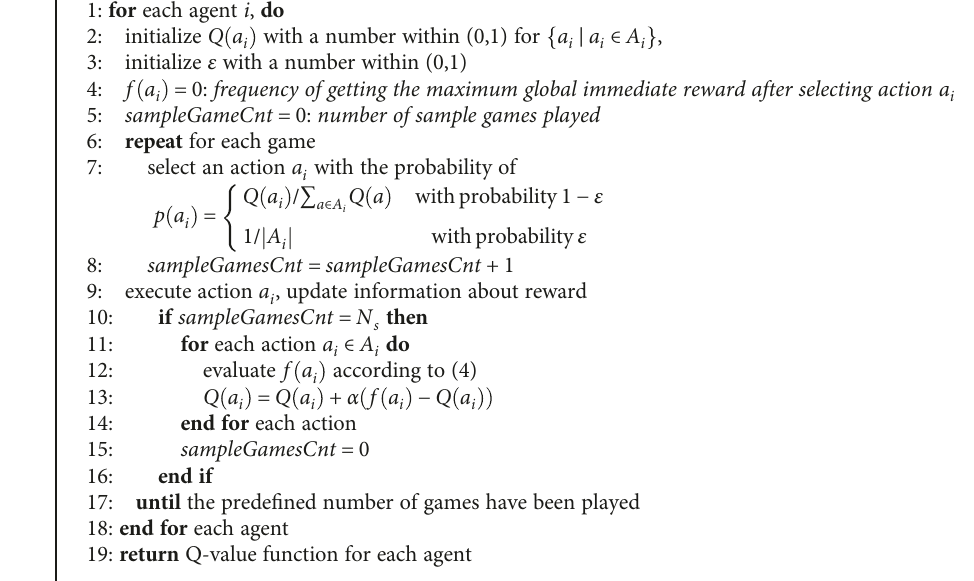
Algorithm 1: EAQR for repeated